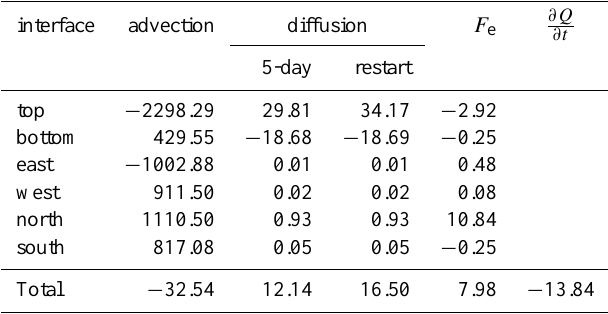
Table 2. As Table 1 but for the region centred at the Equator. In addition the table shows the vertical diffusive flux when using the restart datasets when calculating the Richardson number. Flux in